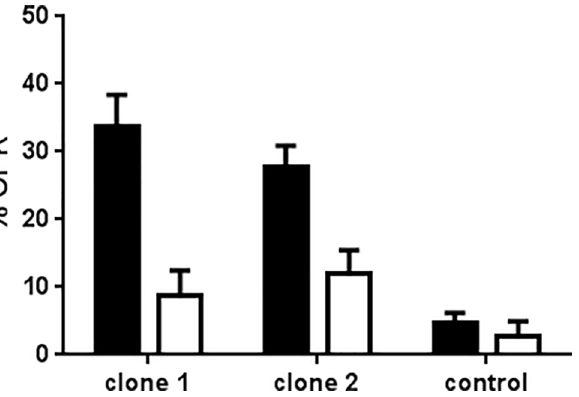
Fig 6. scFv.Fcs expressed in mammalian cells are biologically active. Opsonophagocytosis activity of scFv.Fc fusion proteins for clone 1, clone 2 and negative control clone in supernatants from 293F cells transfected with the respective pSplicev.5 plasmid. Black and white bars represent OPK activity of scFv.Fc at 10 μ g/ml and 1 μ g/ml, respectively. The mean values for each group are derived from experiments done in triplicates and the s.d. is represented by error